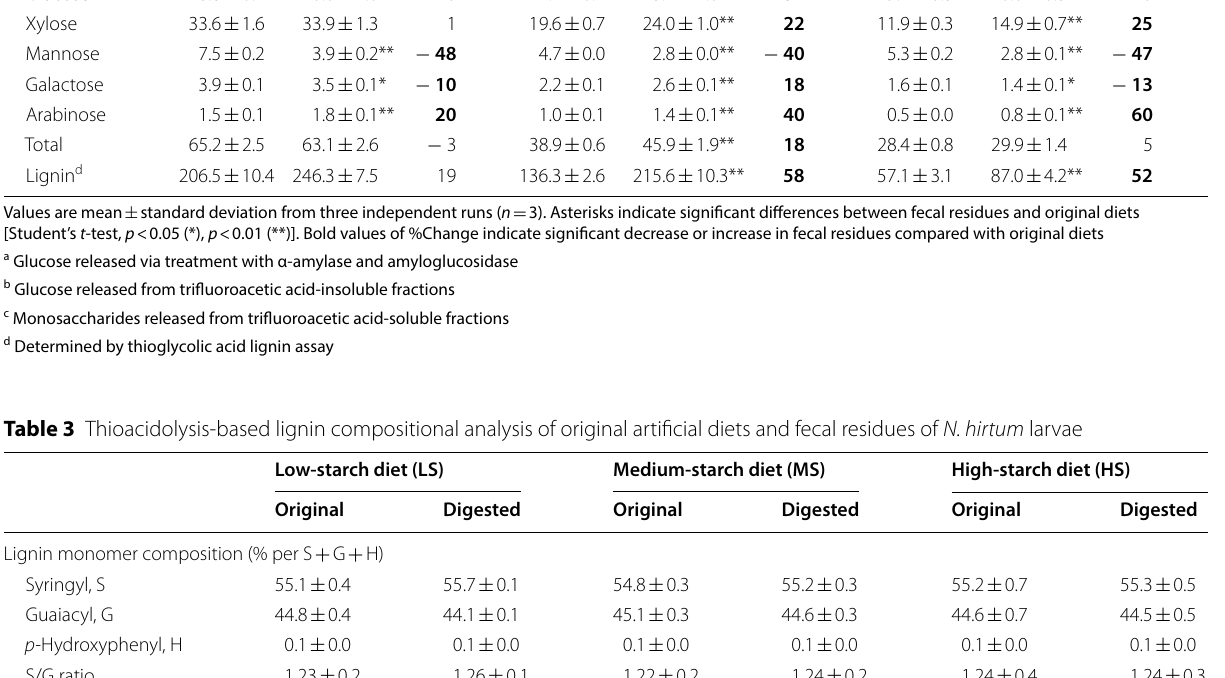
Thioacidolysis was performed on cell wall residue (CWR) samples prepared by sequential extraction of the original diet and fecal residue samples collected after 6-month feeding. Values are mean standard deviation from three independent runs ( n 3). No statistical significancy (Student’s t -test, p < 0.05) was detected ± = between the lignin-derived monomers released from the fecal residues and original